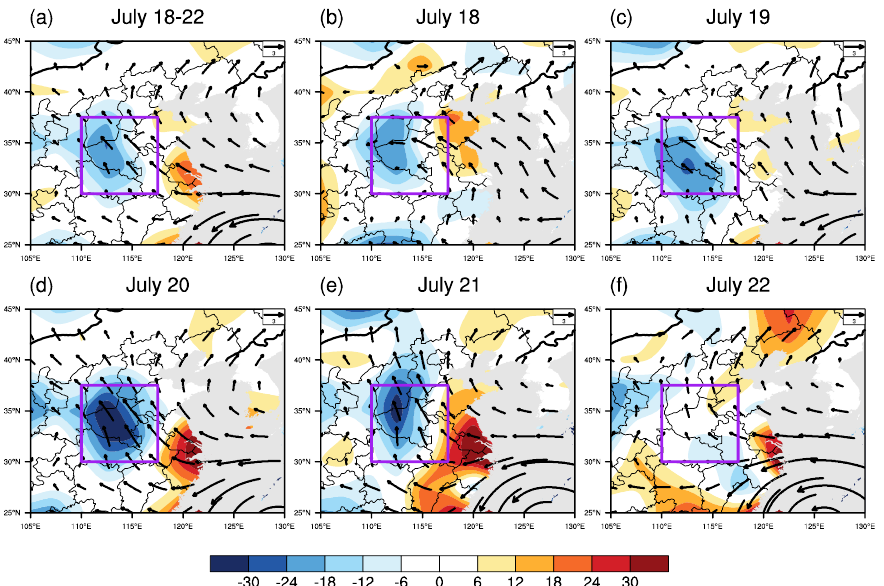
Figure 3. The average and daily water vapor flux (vector, unit: 10 × 10 2 kg/m · s) and convergence anomalies (shading, unit: 10 × 10 −5 ) kg/(m 2 ·s)) during 18 – 22 July 2021. The purple region is Henan province. ( a ) The average and ( b – f ) the daily variation during 18 – 22 July 2021, respectively. Table 2. Net water vapor flux (unit: 10 × 10 7 kg/s) at four boundaries of Henan during 18–22 July 2021. Positive and negative values represent water vapor input and output,